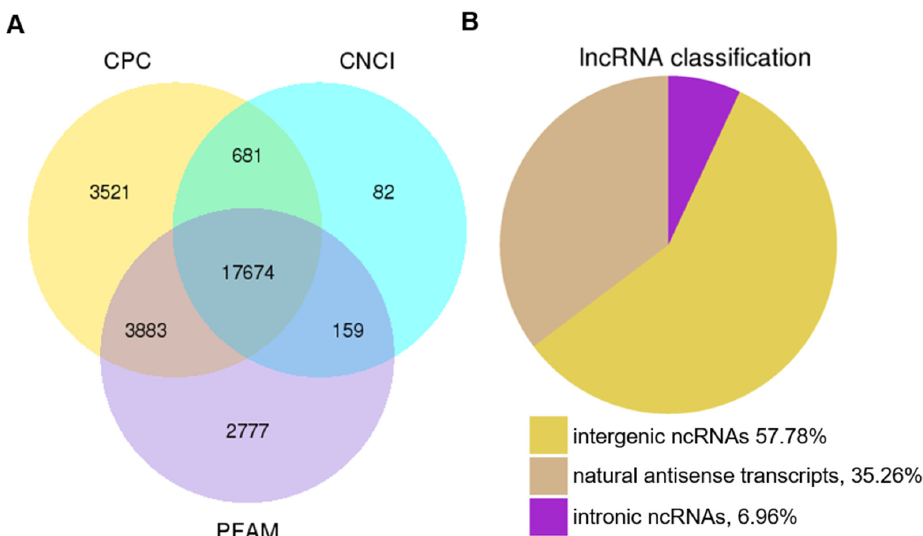
Figure 1. Characterization of all the lncRNAs identified in this study. ( A ) Venn diagram of lncRNA candidates. The coding transcripts were excluded by using the CPC (coding potential calculator), CNCI (coding-non-coding index), and Pfam database. The 17,674 was the number of lncRNAs that were commonly predicted by CPC, CNCI, and Pfam database. ( B ) Classification of the identified lncRNAs. Among 17,674 lncRNAs, 57.78%, 35.62%, and 6.96% are intergenic, natural antisense transcriptional, and intronic lncRNAs, respectively.